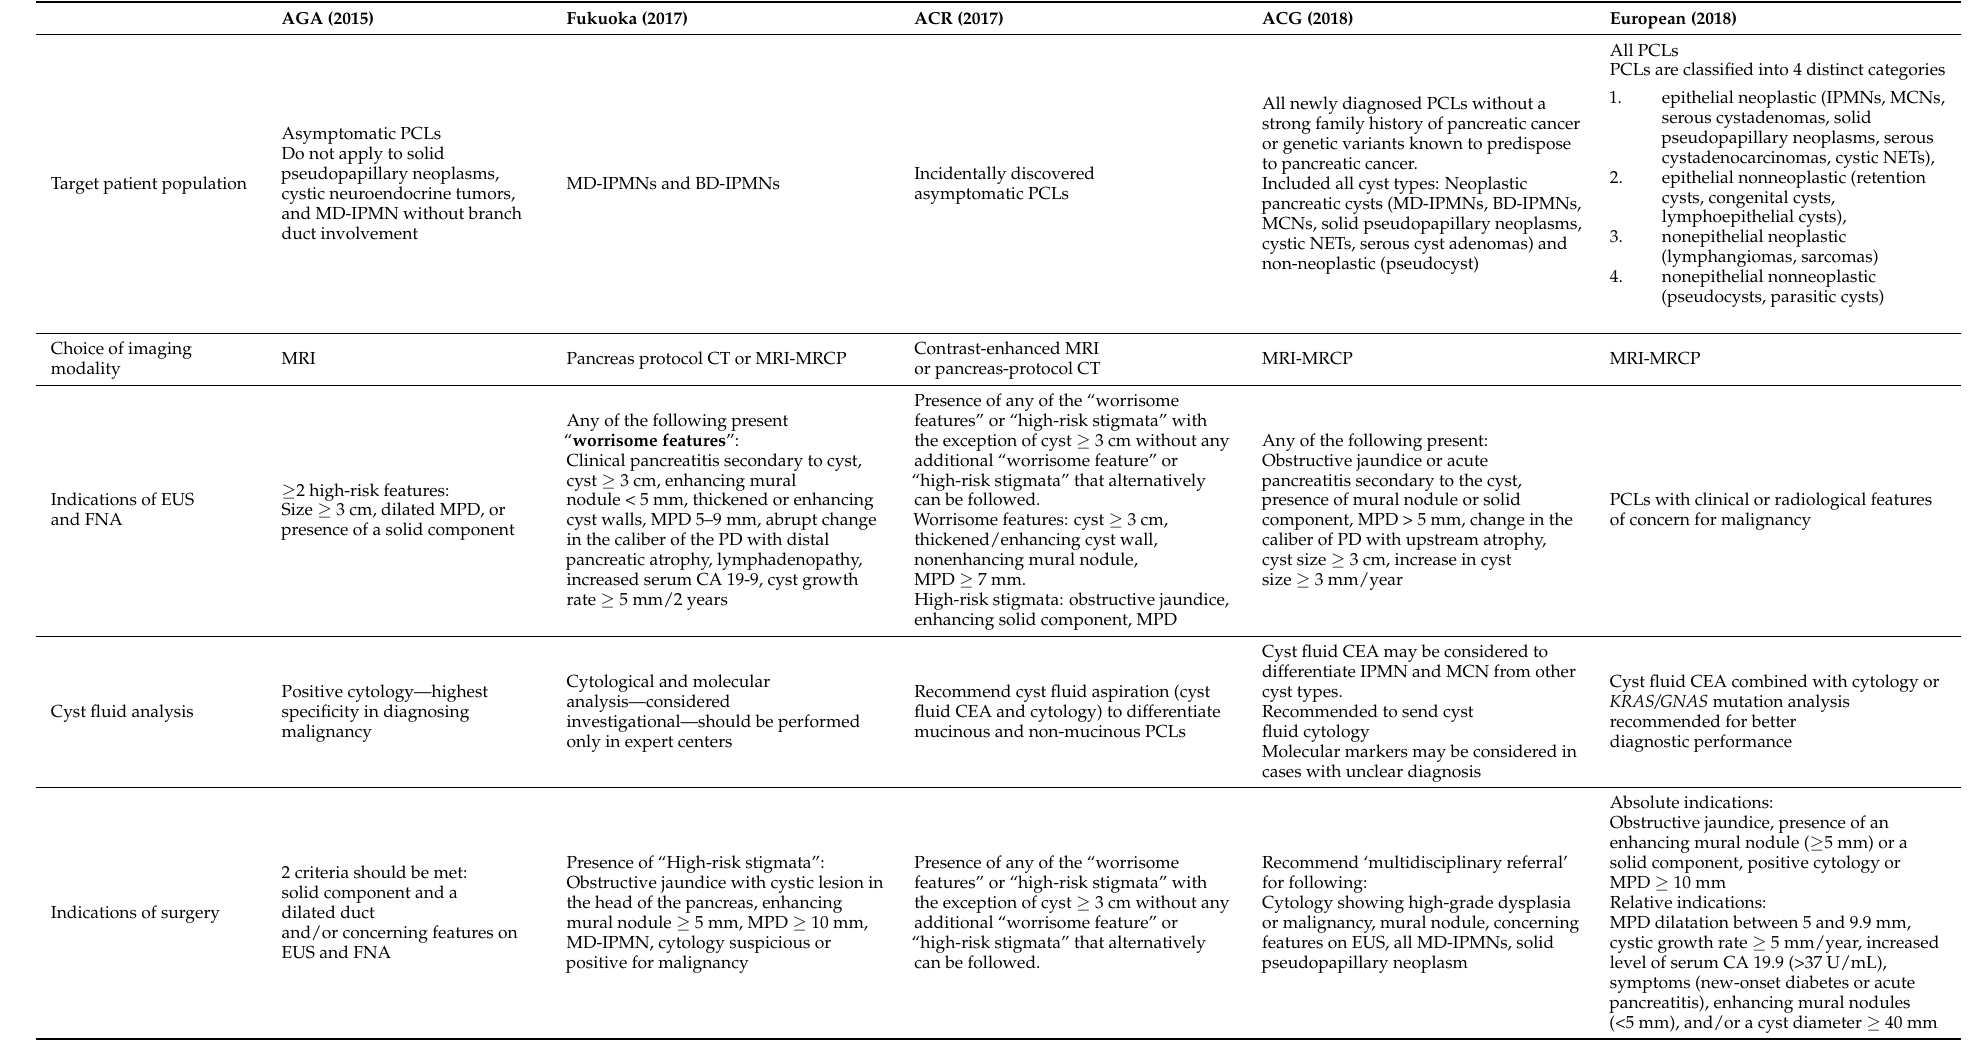
Table 1. Summary of the guideline recommendations for the management of pancreatic cystic lesions